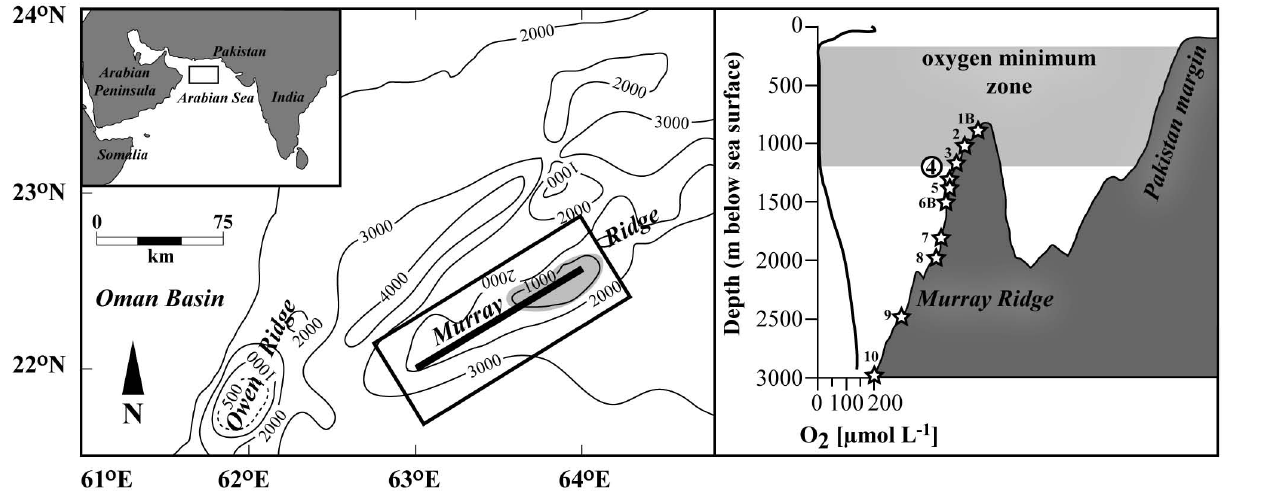
Fig. 1. Left panel: bathymetric map of the Arabian Sea with the location of the Murray Ridge study area indicated with a rectangle. The thick black line in the rectangle specifies the depth transect along which sampling was done in this study. Inset shows general regional geography. Right panel: schematic representation of the Murray Ridge and water column dissolved O 2 profile, with stations indicated with star symbols and station number. Station 4, located in the lower boundary of the OMZ, was used for the reactive transport modelling part of this study (see Sects. 3 and 5) and is